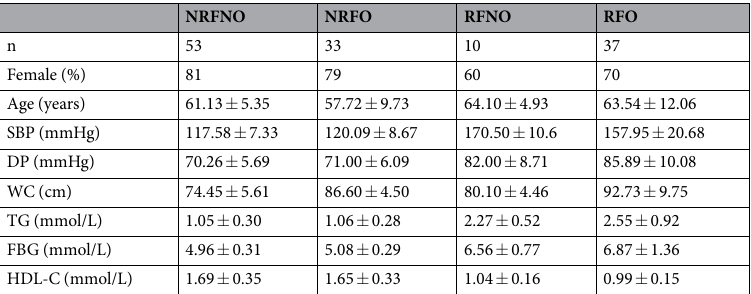
Table 1. Characteristics of participants. NRFNO, group of participants with no cardiometabolic risk factors; NRFO: group of participants with central obesity but no other cardiometabolic risk factors; RFNO: group of participants with no central obesity but all other four cardiometabolic risk factors: RFO: group of participants with all cardiometabolic risk factors; SBP, systolic blood pressure; DBP, diastolic blood pressure; WC, waist circumference; TG, triglycerides; FBG, fasting blood glucose; HDL-C, high-density lipoprotein